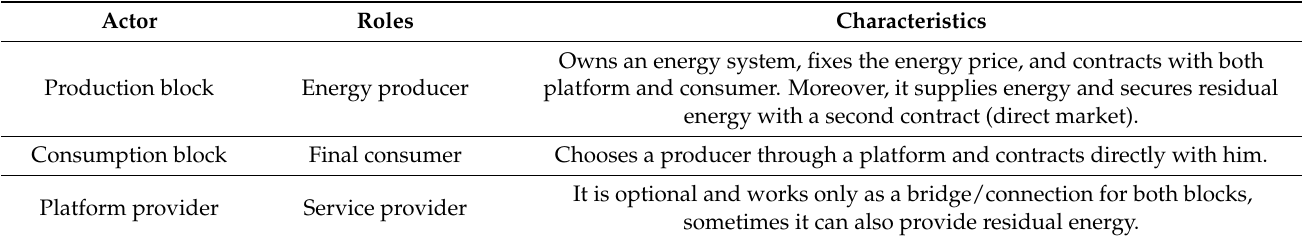
Table 11. Characteristics of the actors’ roles for the direct trading P2P-ET market. Table based on own interpretation from Section